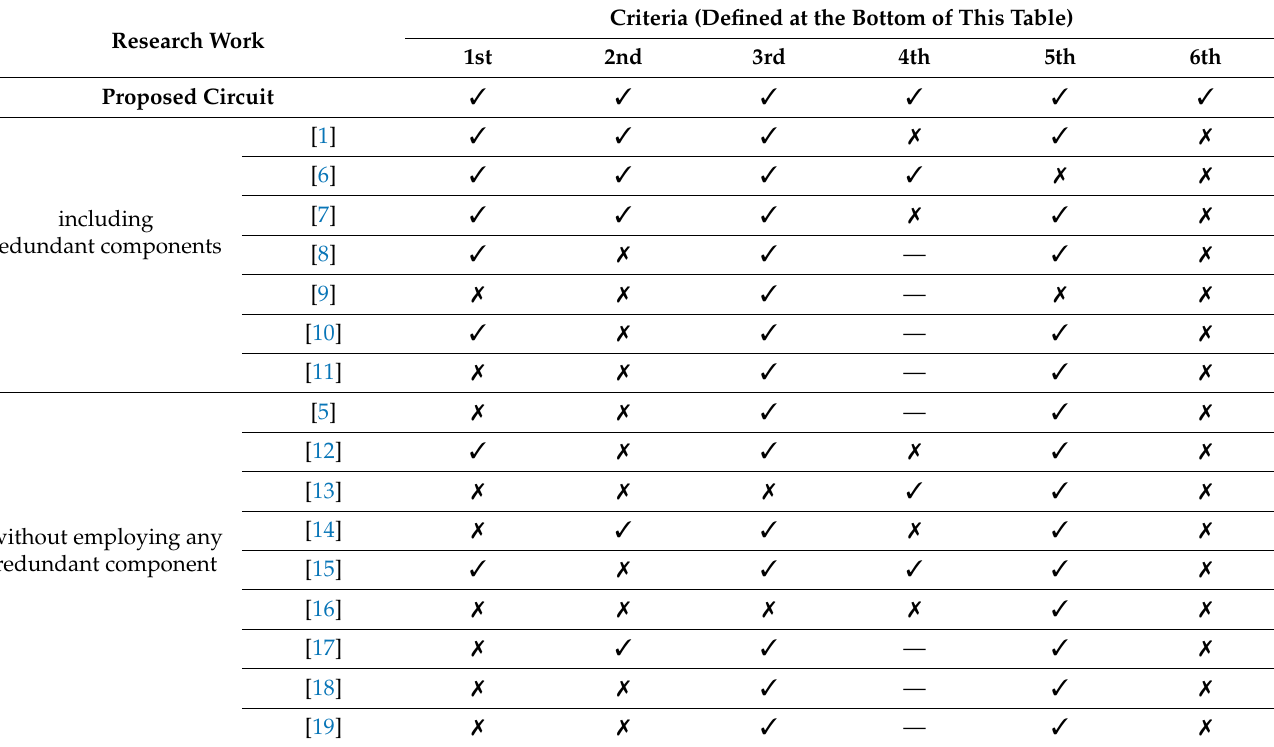
Table 1. Comparison of this research work with the state of the art. Criteria (Defined at the Bottom of This Table) Research Work 1st 2nd 3rd 4th Proposed